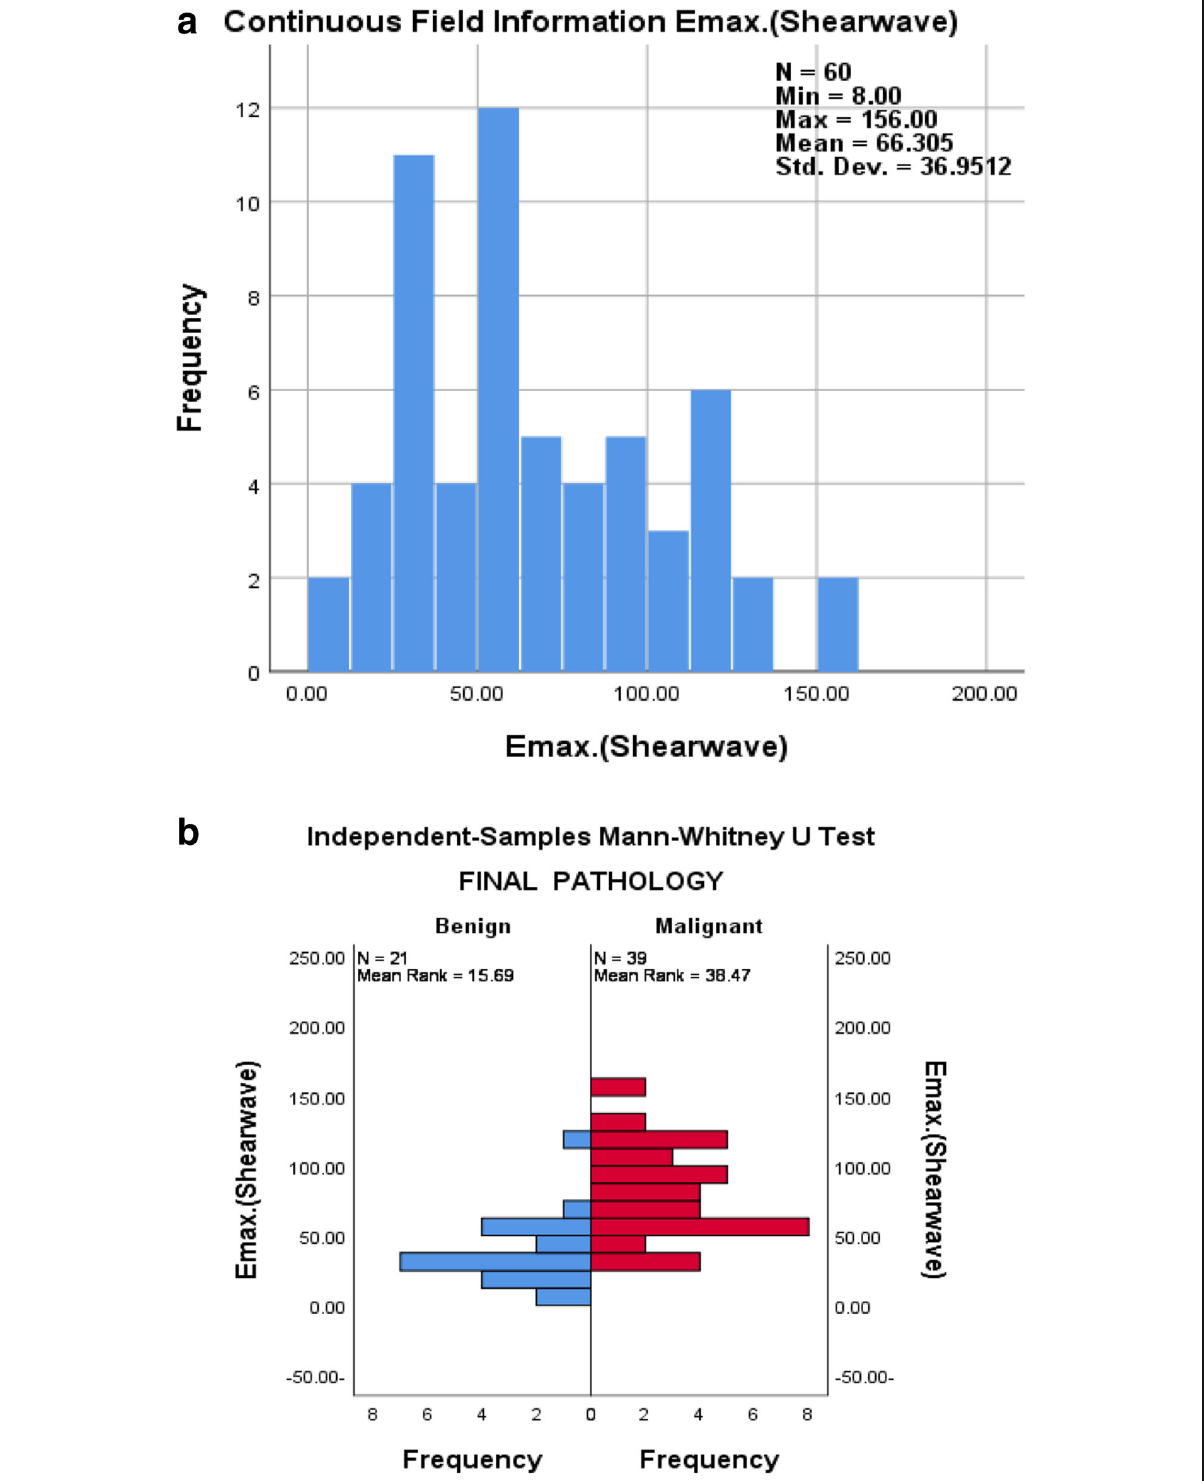
Fig. 1 a Distribution of Emax values for the examined nodes. b Distribution of Emax values for benign and malignant